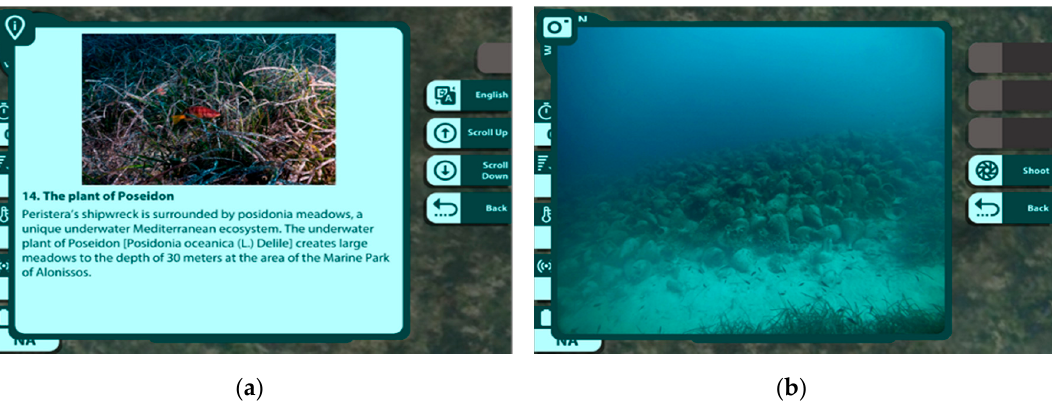
Figure 15. ( a ) the panel with the information about a POI; ( b ) The camera panel within the application.